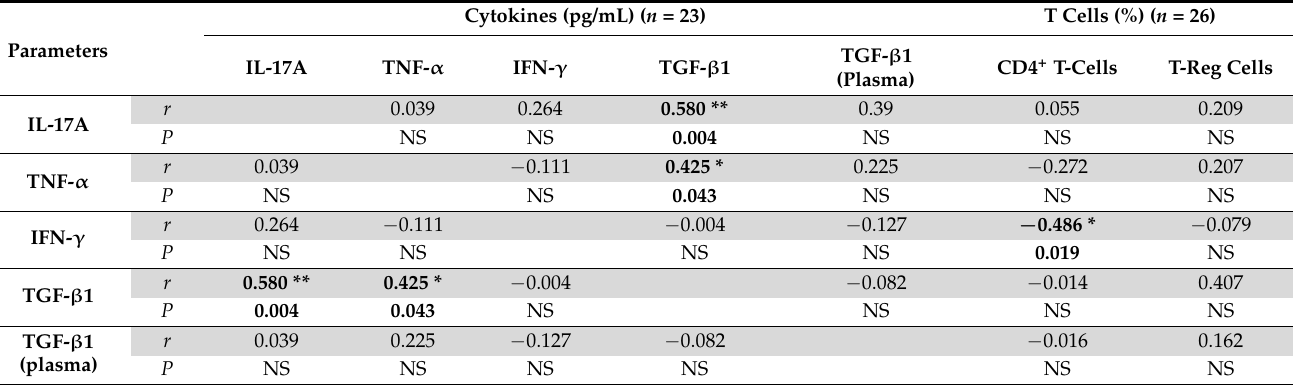
Table 4. Correlation between cytokines from plasma, Con-A-stimulated peripheral blood leukocytes, and T cells.